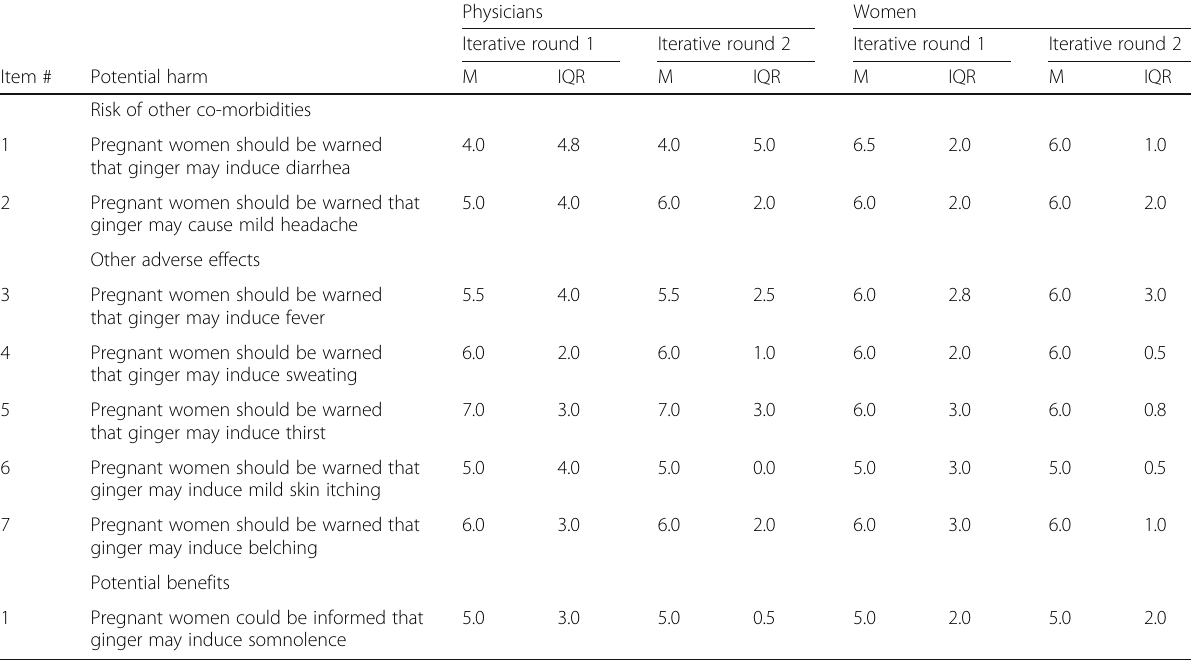
Table 5 Potential harms and benefits to be addressed or not during a clinical consultation depending on the individual clinical situation ’ s